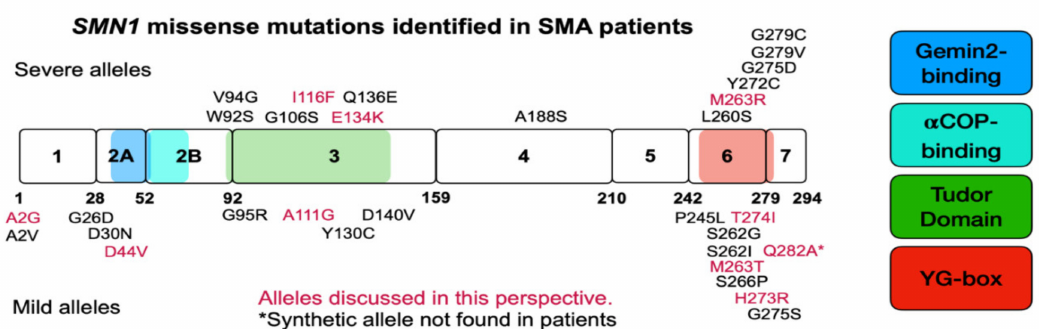
Figure 2. Pictorial representation of SMN exons, domains, and mutations identified in SMA patients. SMN coding region depicted in block form with number designation for exons. Numbers underneath blocks designate the amino acids that end each exon, or are before the translation termination signal. Severe SMN missense mutations are given above blocks and mild mutations are given below blocks, in the approximate location they occur. The mutant alleles given in magenta are discussed within this manuscript. The colored boxes indicate domains of SMN in order from left to right: Gemin2- binding, alpha-COP-binding, Tudor Domain, and YG-box oligomerization domain. Please consult Table 1 for more detailed information about each missense mutation, the SMA type, SMN2 copy number, and